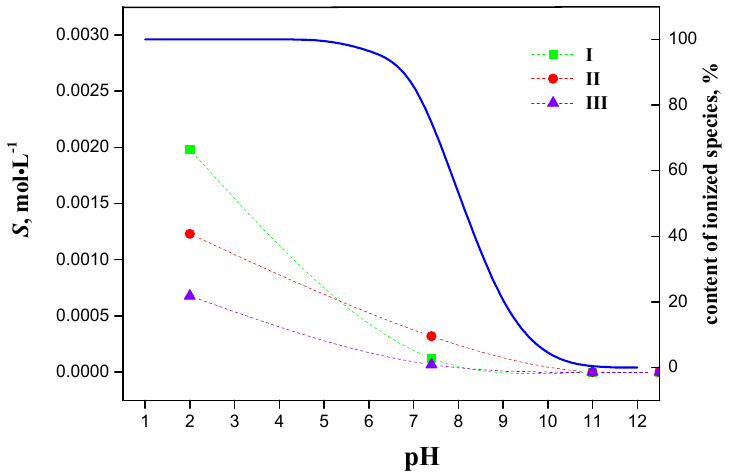
Figure 4. Characteristic ionization profile of compounds studied (blue line) and corresponding experimental solubility values at T = 298.15 K.